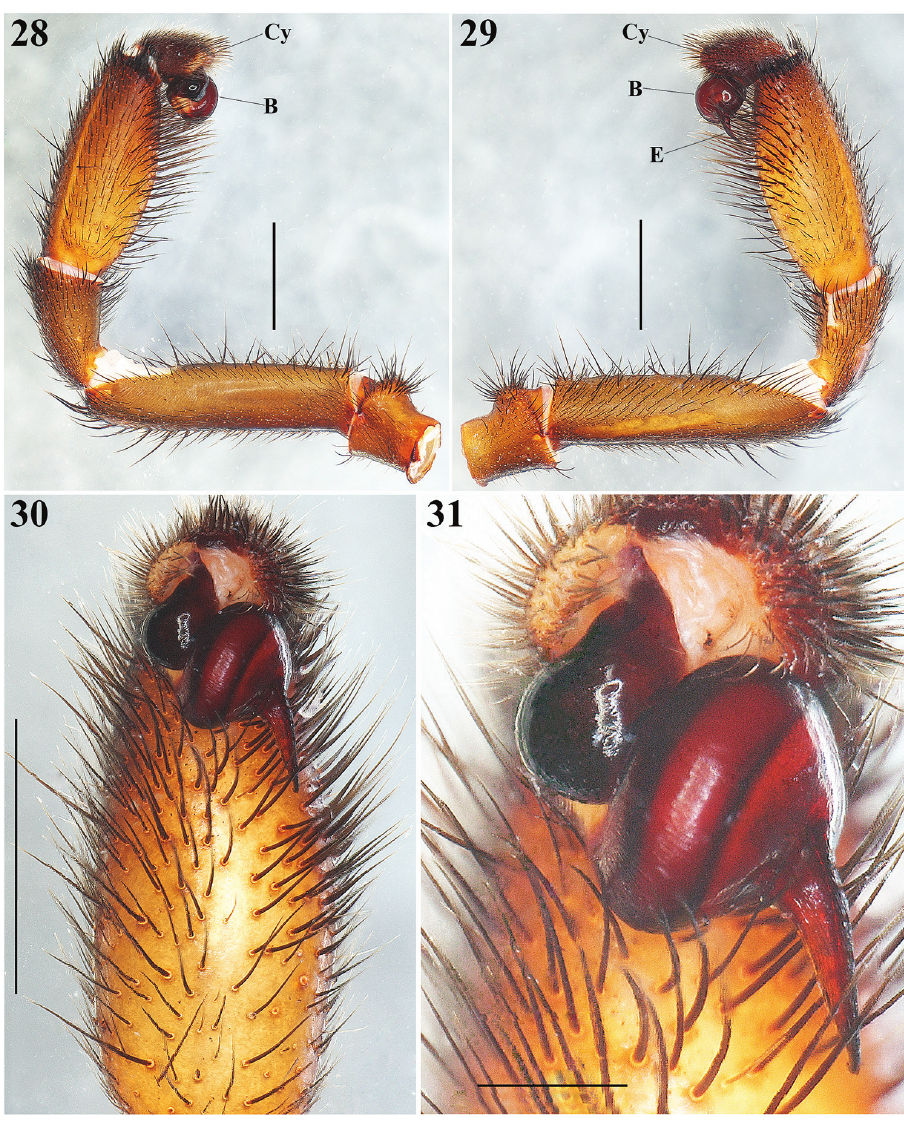
Figures 28–31. Eucteniza zapatista Bond & Godwin, 2013. Male: 28–29 Left palp, prolateral and retrolateral views respectively 30 Left palp, ventral view 31 Detail of the bulb and embolus, ventral view. Scale bars 0.5 mm ( 31 ), 2 mm ( 28–30